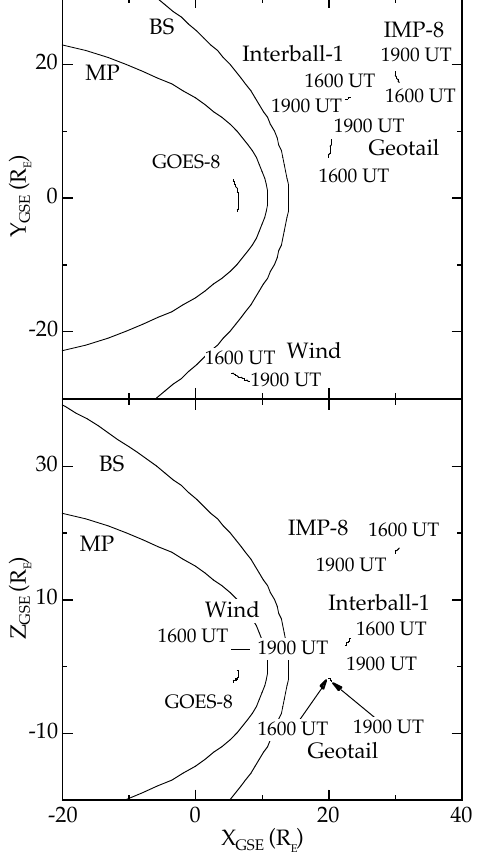
Figure 2. Ecliptic and meridional projections of Geotail, Interball-1, Fig. 3. A summary plot of IMP-8, Interball-1, Geotail, and Wind Fig. 2. Ecliptic and meridional projections of Geotail, Interball-1, IMP-8, Wind, and GOES-8 trajectories from 1600 to 1900 UT on solar wind and foreshock observations from 16:00–19:00 UT on IMP-8, Wind, and GOES-8 trajectories from 16:00 to 19:00 UT on 19 April 1996. The first triplet of panels depicts the IMP-8 GSFC 19 April 1996. For comparison, the figure also shows the nominal April 19, 1996. For comparison, the figure also shows the nominal magnetic field strength, MIT ion plasma density, and EPE energetic positions of the bow shock and magnetopause. ion observations. The second triplet of panels shows Interball-1 positions of the bow shock and magnetopause. MIF-M magnetic field strength, VDP ion plasma flux, and DOK-2 energetic ion flux observations. The third triplet of panels shows Geotail MGF magnetic field strength, LEP ion plasma density, and EPIC energetic ion flux observations. The fourth triplet of panels shows Wind MGI magnetic field strength, 3-DP ion plasma density, and 3-DP energetic ion phase space density observations. Located even further upstream, IMP-8 observed three bursts of energetic (50–220 keV) ions, from 16:17 to 16:39, 16:50 to 17:33, and 17:52 to 18:11 UT, again corresponding to the three bursts at Geotail. The time resolution of the IMP- 8 plasma observations does not suffice to determine whether decreases in the density corresponded to bursts of energetic ions or whether the density and magnetic field perturbations were in phase or antiphase. However, because the energetic ion bursts did not correspond to decreases in the magnetic field strength, the bursts at IMP-8 cannot be interpreted as foreshock cavities. Note, however, that there was a small ( ∼ 1 nT) decrease in the IMP-8 magnetic field strength when the energetic ion flux peaked at 16:38